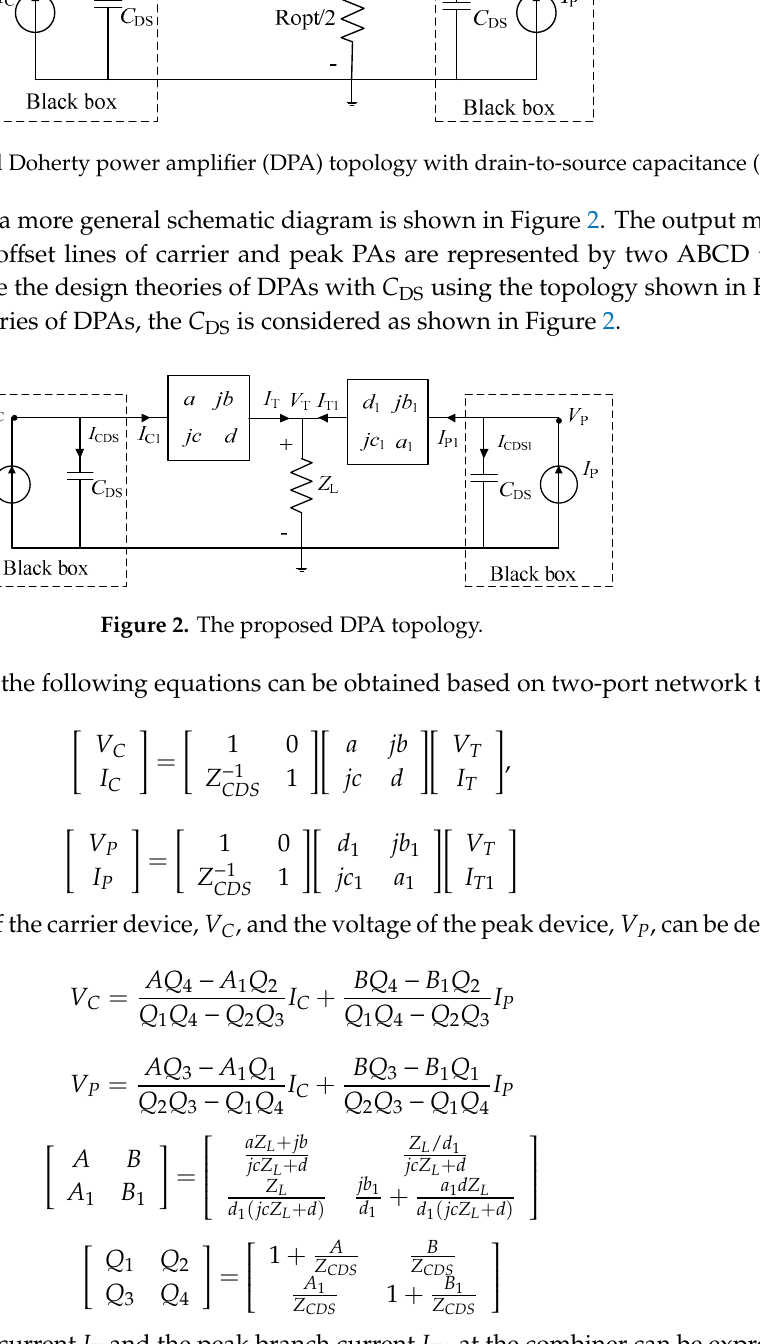
Figure 1. Conventional Doherty power amplifier (DPA) topology with drain-to-source capacitance ( C DS ).